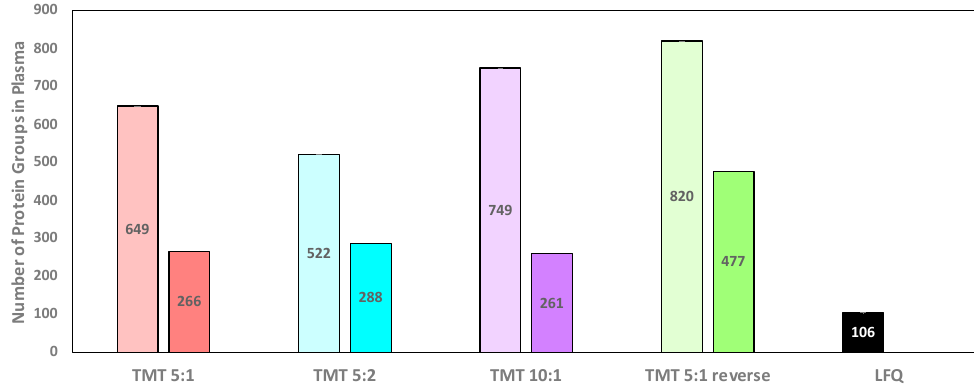
Figure 1. Number of proteins identified across all seven plasma samples for each methodology. The light-colored left bar depicts the total number of unique proteins identified across the two replicate experiments, and the darker right bar for each method depicts the number of proteins identified in both replicate experiments. Data can be found in Supplementary Tables.